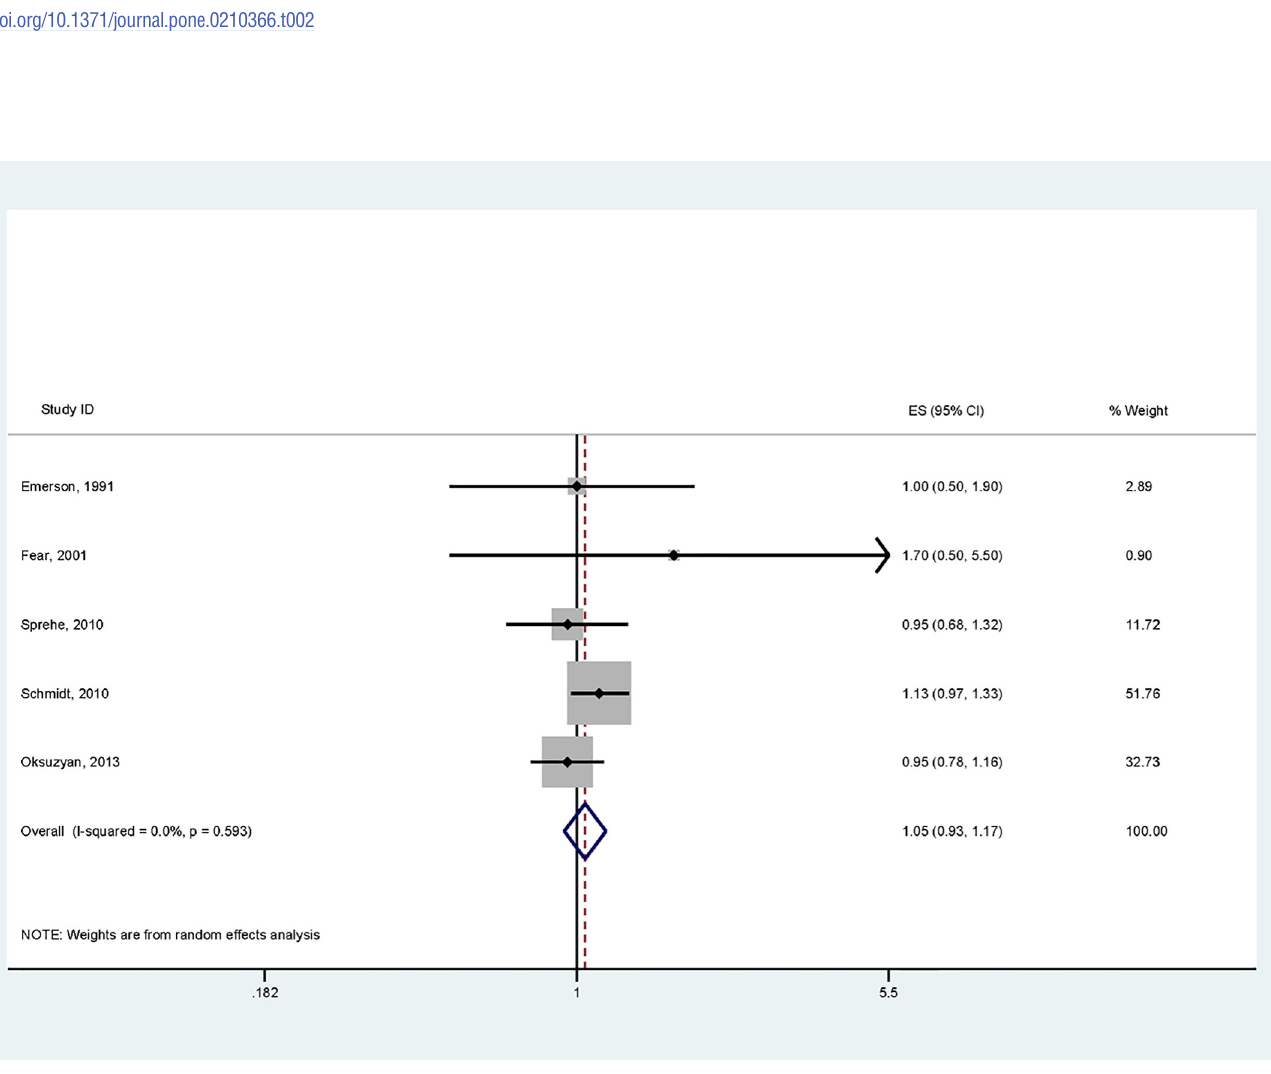
Fig 2. Forest plot of GA < vs � 37weeks and the risk of developing a primary central nervous system